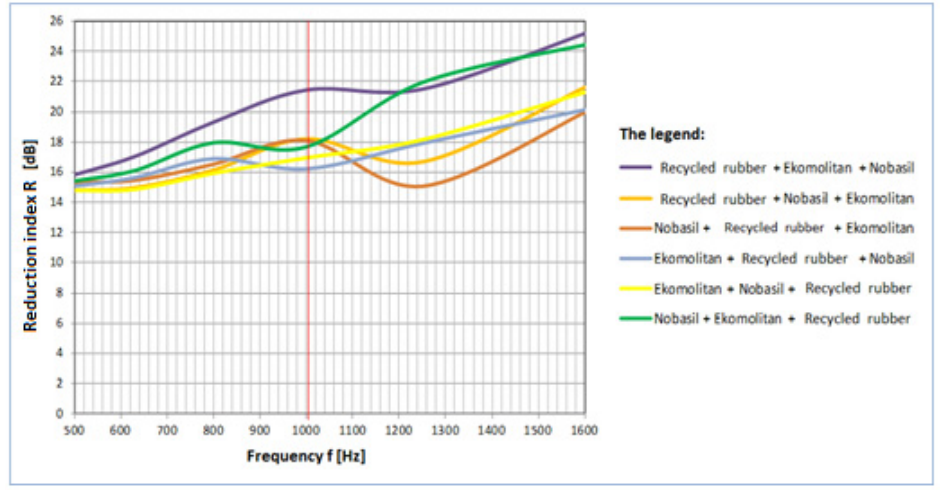
Figure 13. Reduction index R of two ‐ layered sandwich absorbers (material thickness—60 mm).